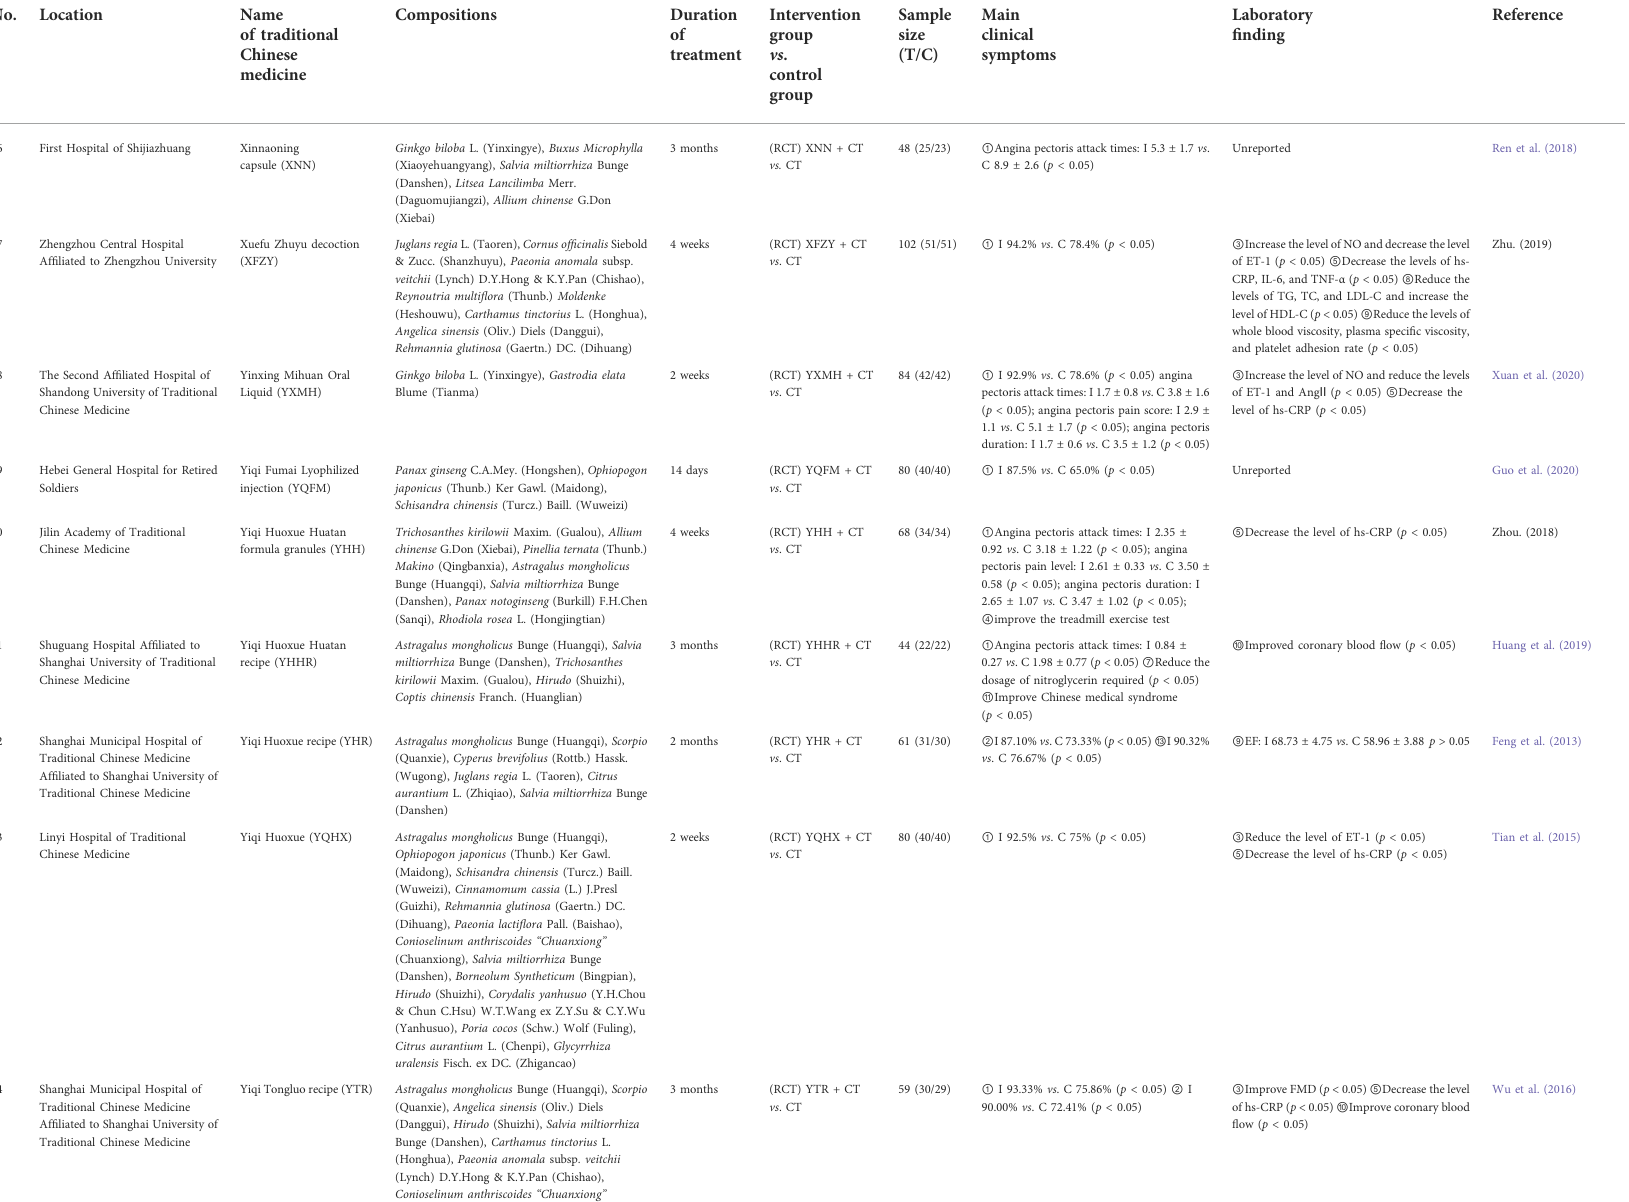
TABLE 1 ( Continued ) Clinical evidence of TCM for